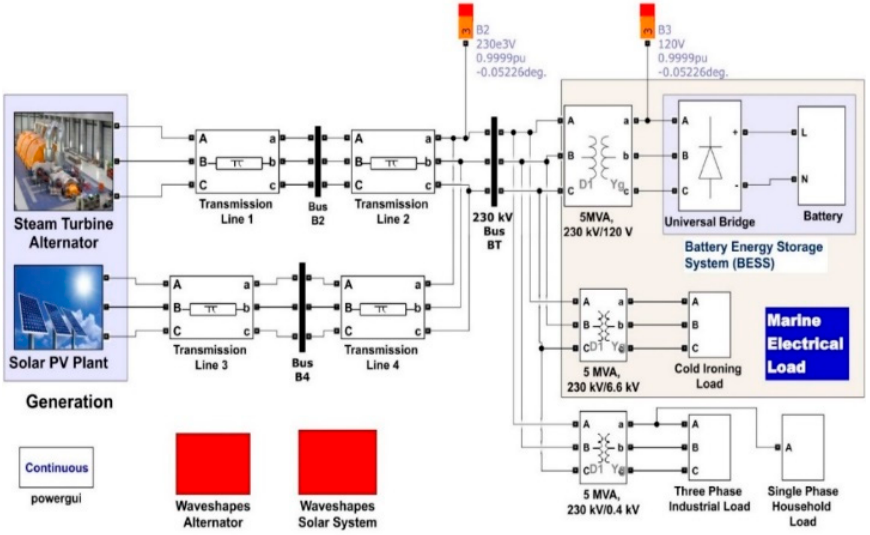
Figure 1. Simulated model of a grid connected battery charging system.